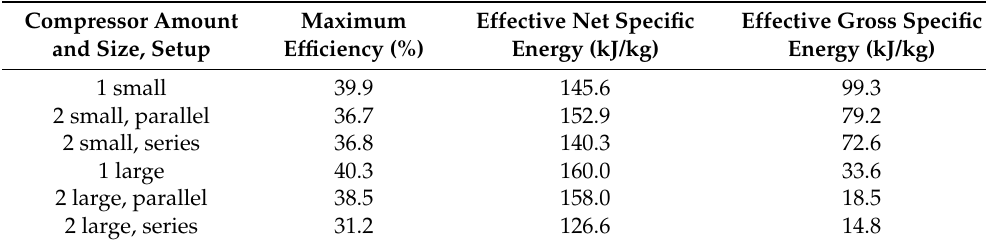
Table 3. Experimental values for maximum efficiency and effective net and gross specific energy of small and large diaphragm compressors, based on [16].